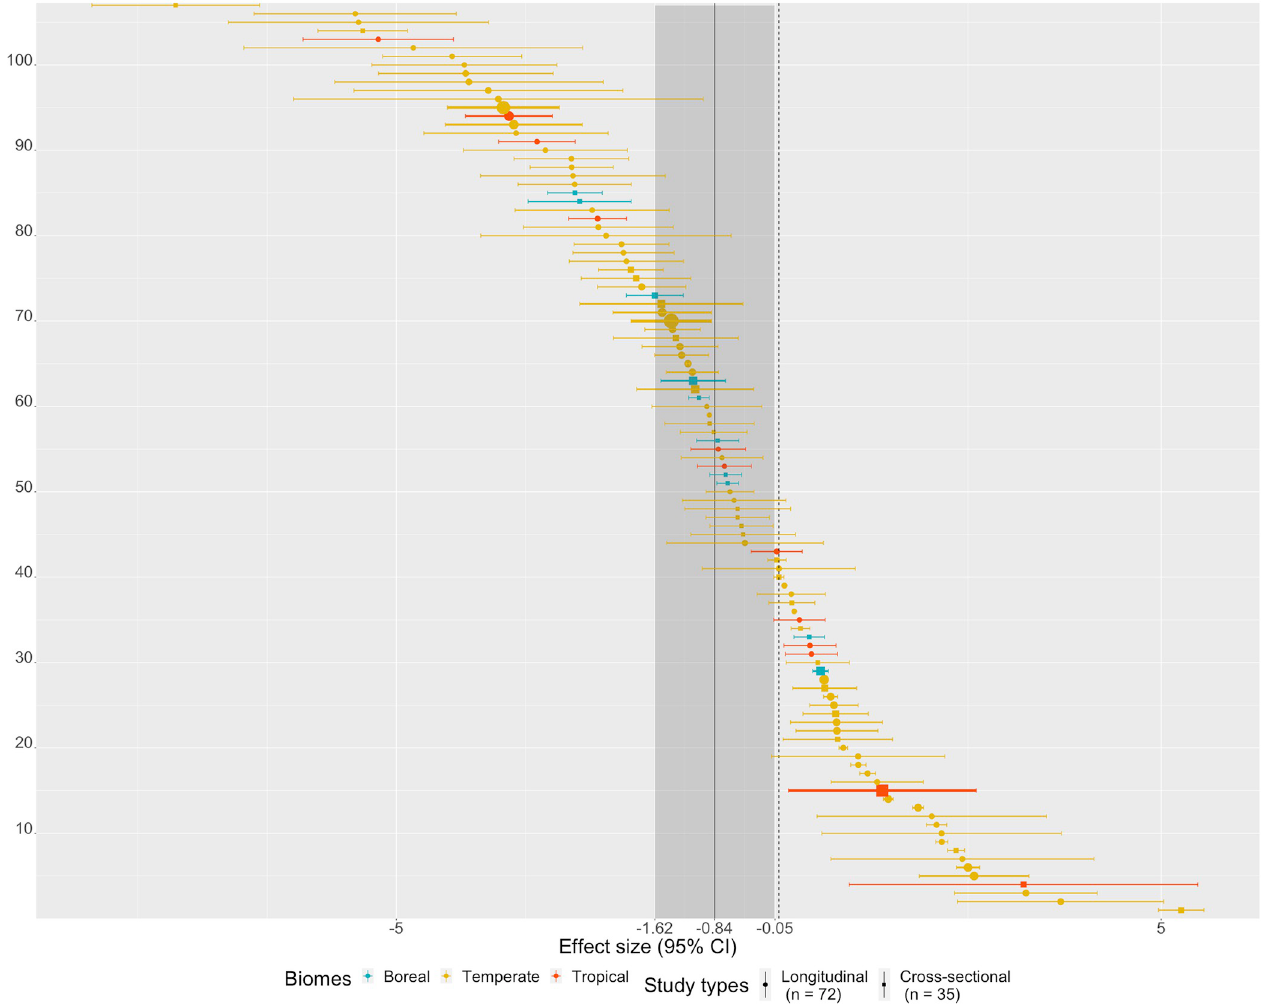
Fig 3. Forest plot of the meta-analysis. The mean effect size is -0.84 (95% CI = -1.62 to -0.05, shaded grey area), where study type is shape-coded (i.e., circle for longitudinal studies and squares for cross-sectional studies) and biome color coded (i.e., boreal in blue, temperate in yellow and tropical in red). A negative effect size means that there is a negative impact of hydropower in impacted sites as opposed to reference sites, whereas a positive effect size means that there is positive impact of hydropower in impacted sites as opposed to reference sites.